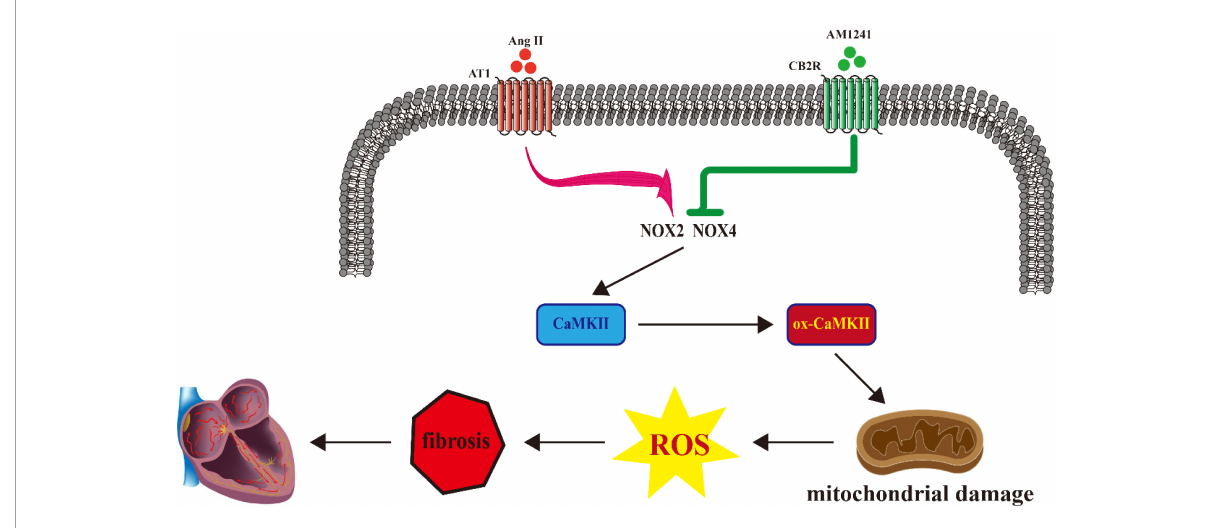
FIGURE6 Proposed model describing the role of cannabinoid receptor 2 (CB2R) activation in the treatment of atrial fibrillation